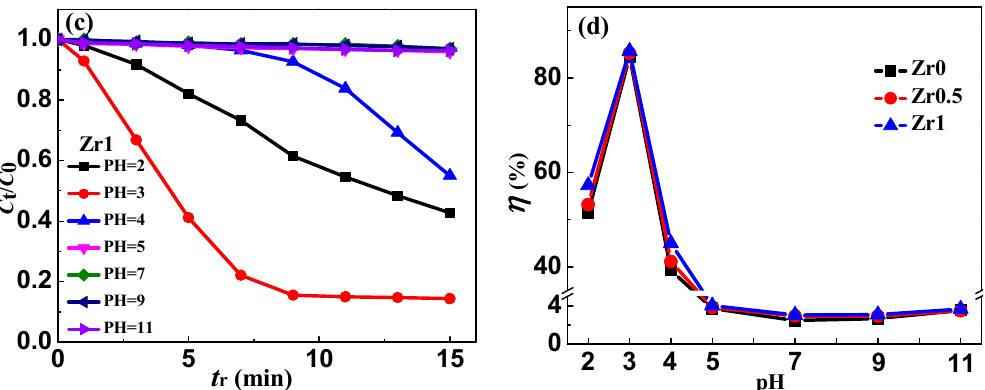
Figure 6. The normalized concentration C t / C 0 change of MB solution during the degradation process of the as-spun ( a ) Zr0, ( b ) Zr0.5 and ( c ) Zr1 ribbons at different pH values. ( d ) The degradation efficiency ( η = (1 − C t / C 0 × 100%, t = 15 min) of the degradation process vs. pH for Zr0, Zr0.5 and Zr1 ribbons.